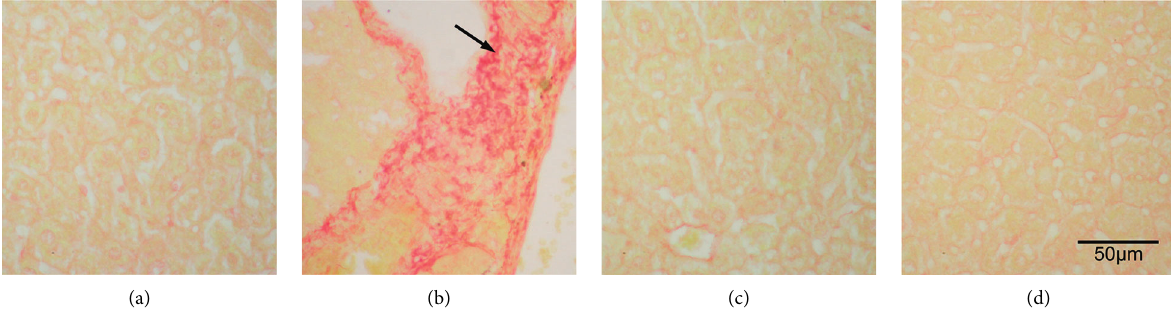
Figure 2: Sirius red stain of the saline- (a), ethanol- (b), fluoxetine- (c), and atorvastatin-treated (d) liver. Fibrosis (arrow) was noted in the ethanol-treated liver (b), 400X.